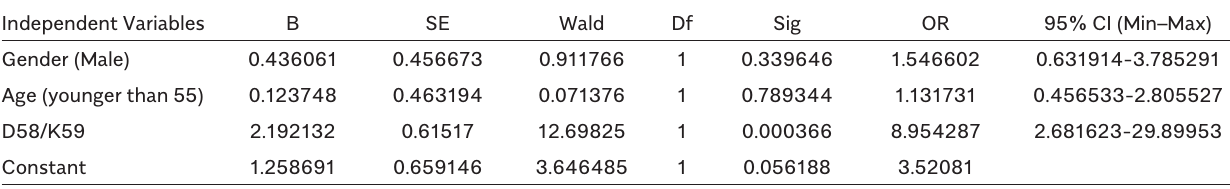
Constant B, beta regression coefficient; SE, standard error; df, degree of freedom; OR, odds ratio; Sig, significance. Table 7. Results of Logistic Regressions Analysis According to the Variables in Duodenal Ulcer Cases Independent Variables B SE Df 95% CI (Min–Max) Gender (Male) − 0.69182